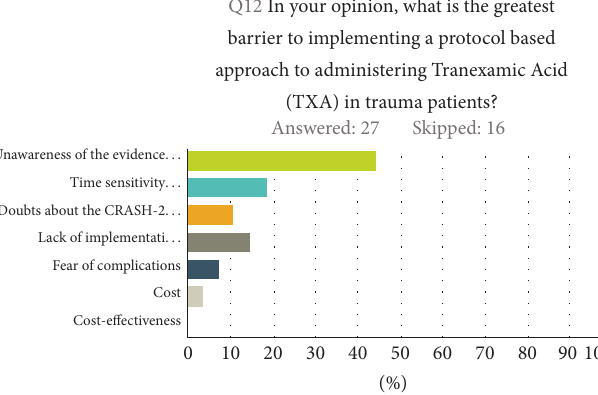
Figure 3: Greatest barrier to implementing TXA in trauma patients.